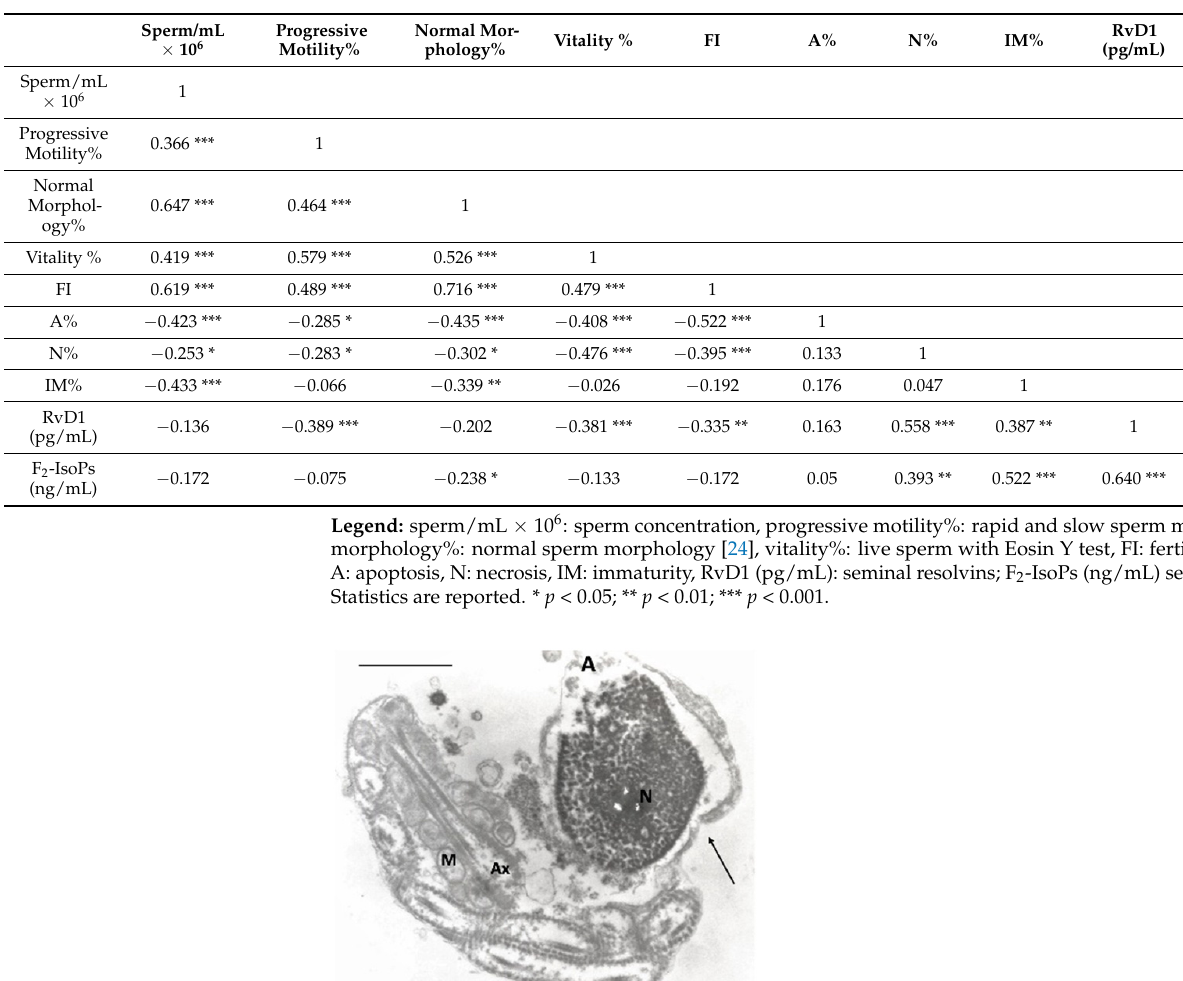
Table 2. Correlations (rho Spearman’s coefficient) between all considered variables in 85 individuals.